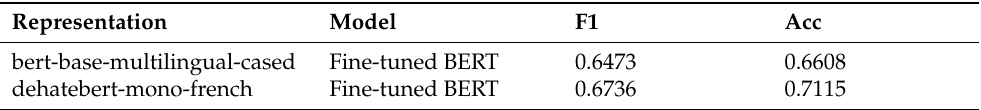
Table 6. FTR standalone evaluation results (accuracy and